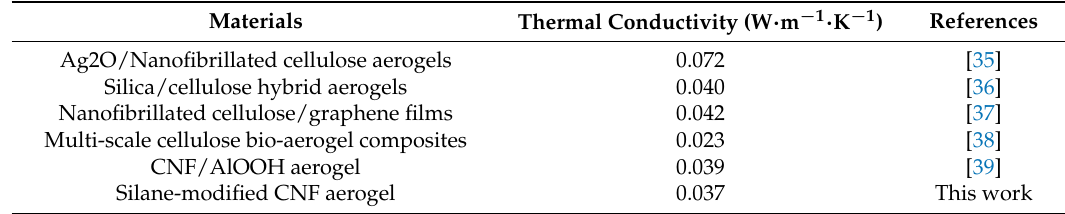
Table 2. Thermal conductivity values of some cellulose-based materials.